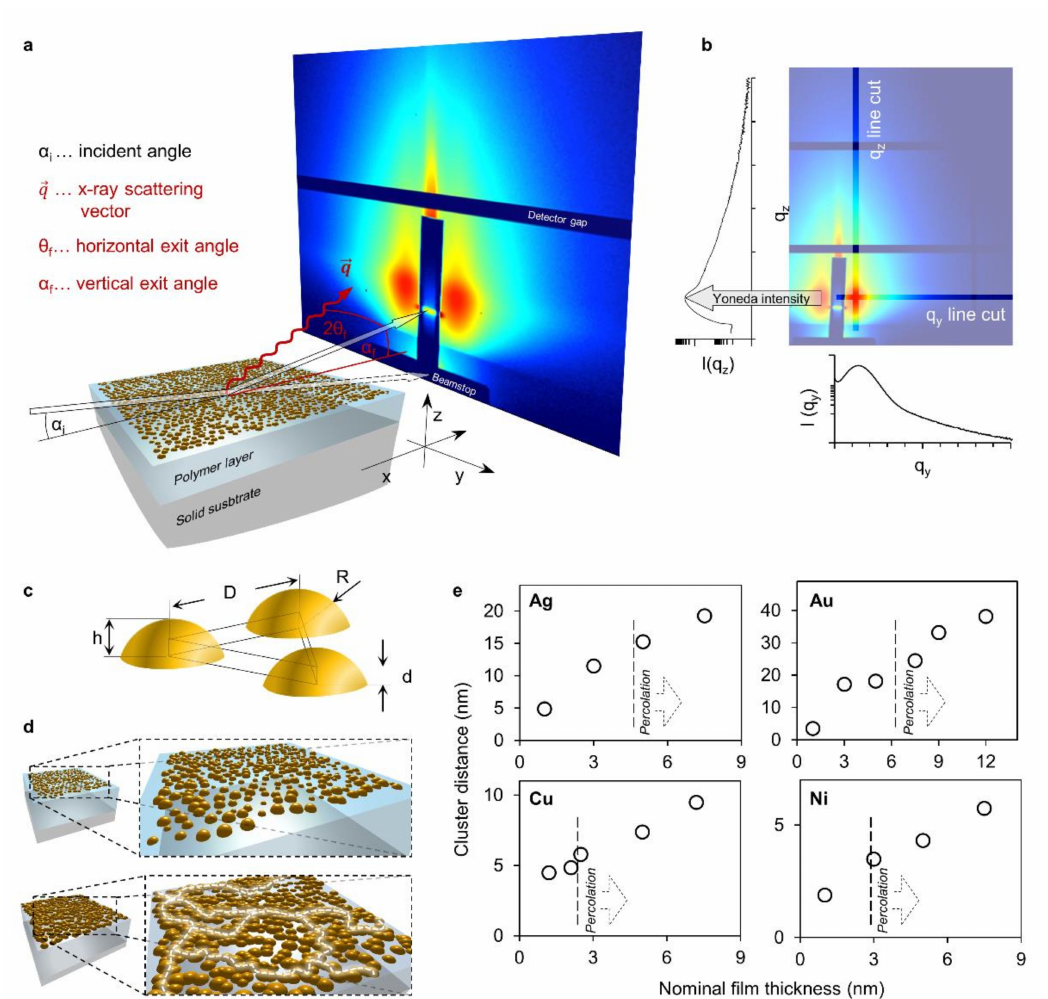
Figure 4. Grazing incidence small-angle X-ray scattering (GISAXS) experimental setup with line cuts, approximate cluster geometries and characteristic cluster distances; ( a ) schematic representation of the experimental setup used to obtain 2D X-ray scattering patterns at grazing incidence; ( b ) example of a 2D scattering pattern where the positions of cuts along the y- and the z -axis are indicated while the resulting scattering curves are plotted below and left of the pattern, respectively. The position of the Yoneda intensity, the z position where cuts along the y -axis are made, is indicated; ( c ) schematic representation of an idealized equilateral triangular unit cell of spherical cap shaped clusters; ( d ) conceptual progression of isolated clusters of metals percolating into a conductive network. Sufficient disorder results in irregularly shaped clusters and the formation of conductive paths as indicated by white dashed lines; ( e ) the distance estimated by Kratky analysis of the prominent scattering features caused by the interference function of the cluster arrangement plotted versus the nominal thickness. The respective metal is indicated in the upper left corner. The respective percolation thresholds and onsets of conduction are indicated by dashed